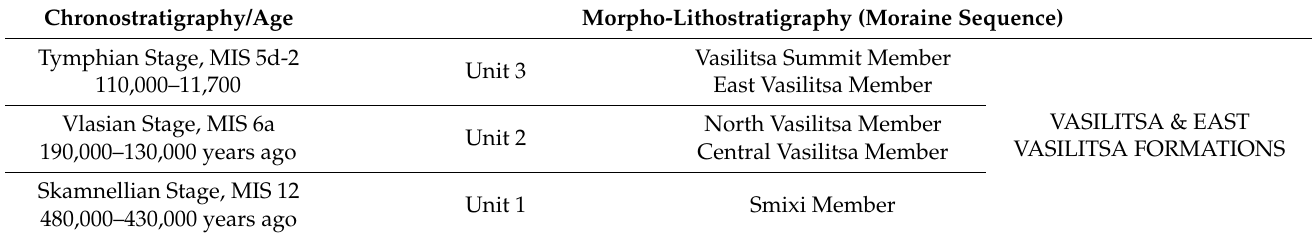
Table 2. Chronostratigraphy and morpho-lithostratigraphy of the moraine sequence in the north- eastern valley of Mount Vasilitsa. From Hughes